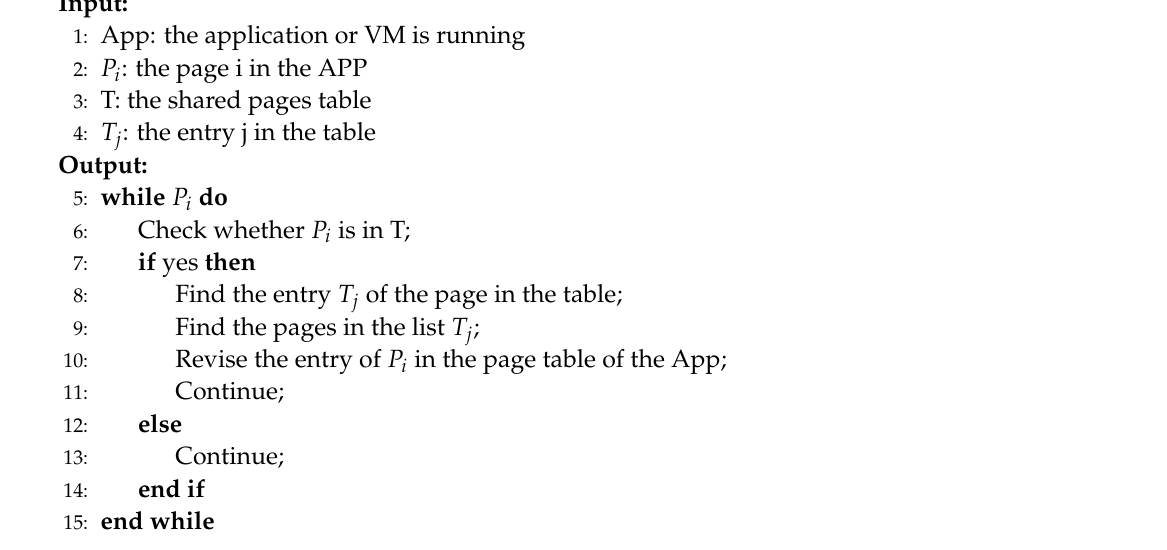
Algorithm 3 Implementation of memory